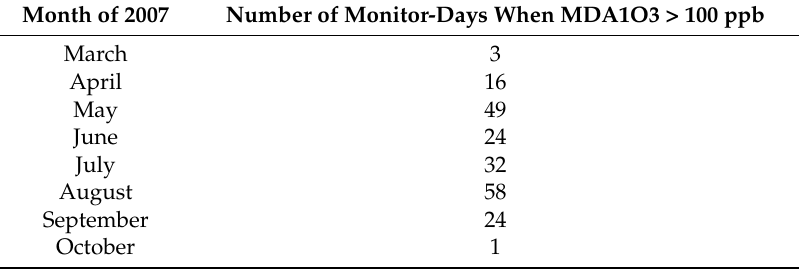
Table 1. Number of monitor-days in the southern part of South Korea during 2007 when maximum daily one-hour ozone concentration (MDA1O3) was over 100 ppb.